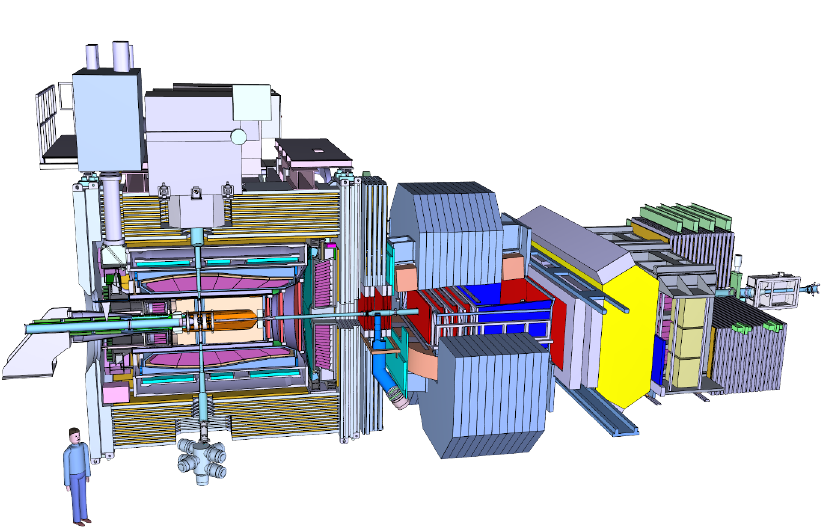
Figure 2. Schematic overview of the full PANDA setup. The antiproton beam will run from left to right, and the target jets / pellets from top to bottom. The left part of the detector surrounds the interaction point and is the Target Spectrometer, whereas the right part is the Forward